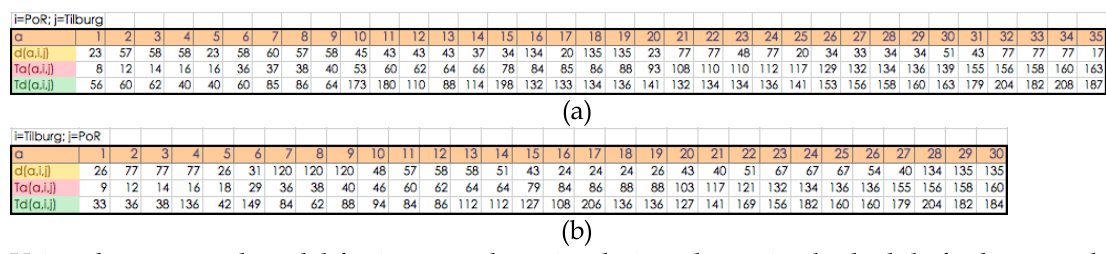
Table 2. Container transport demand data for a random week (a) from PoR to Tilburg (matrix